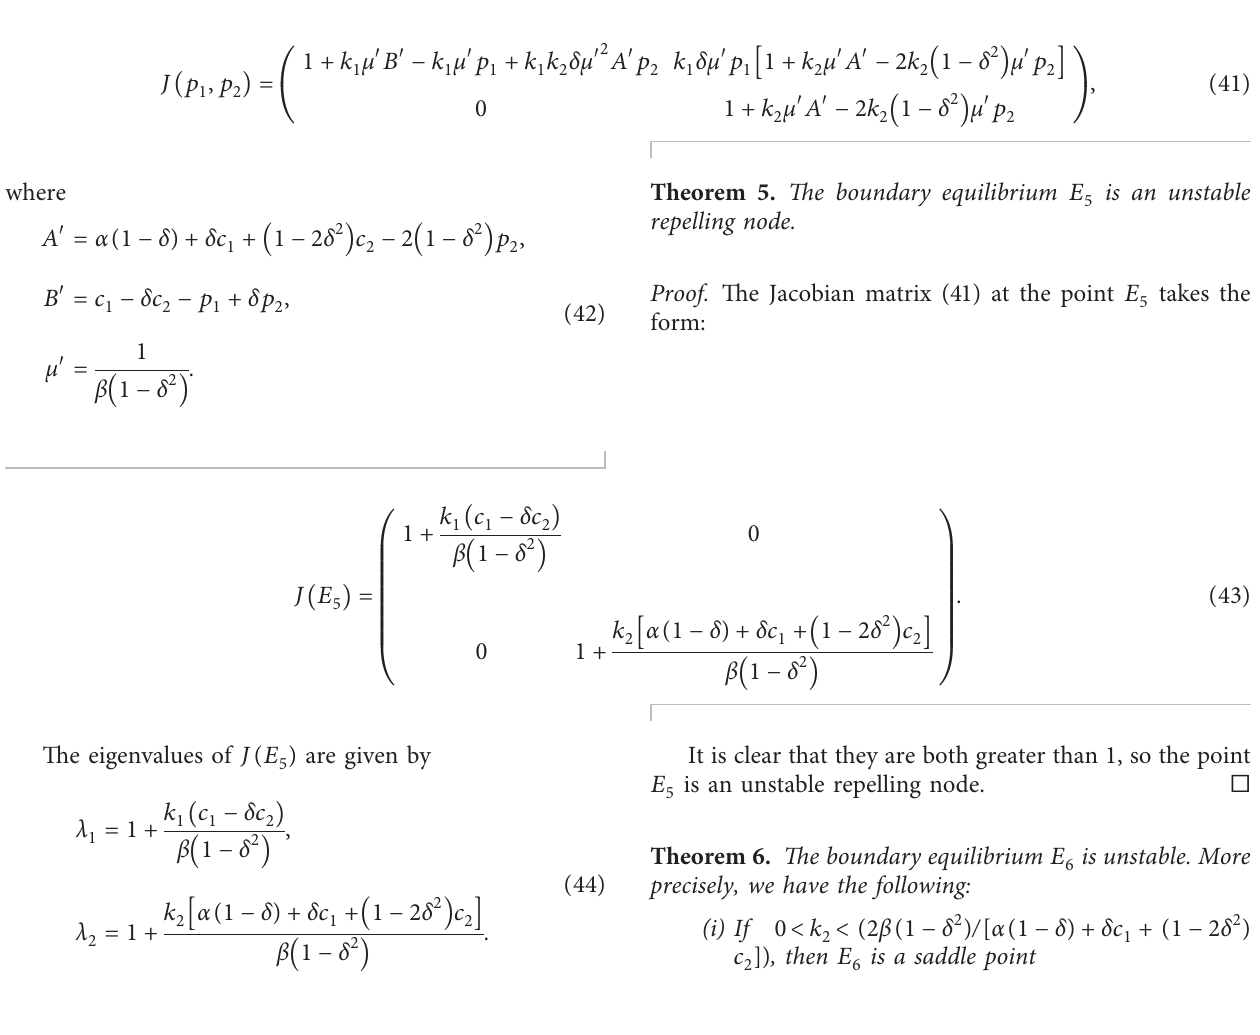
,k ) -plane of Nash equilibrium point E 1 2 , k ) -plane of Nash equilibrium point E for system (38) with different levels of δ . The other values of the parameters are 1 2 8 � 0 . 13, and c � 0 . 1 2